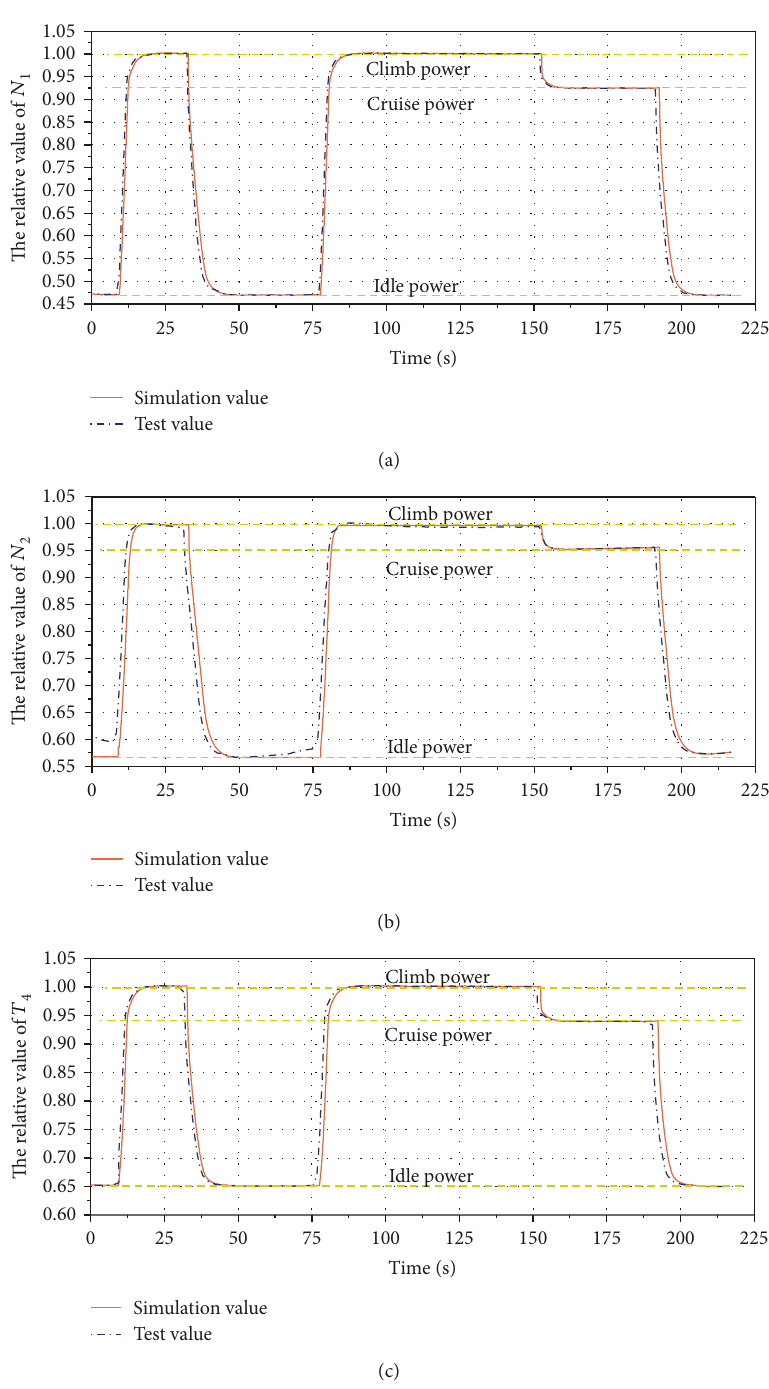
Figure 5: The results of transition state simulation. (a) Variation curve of N